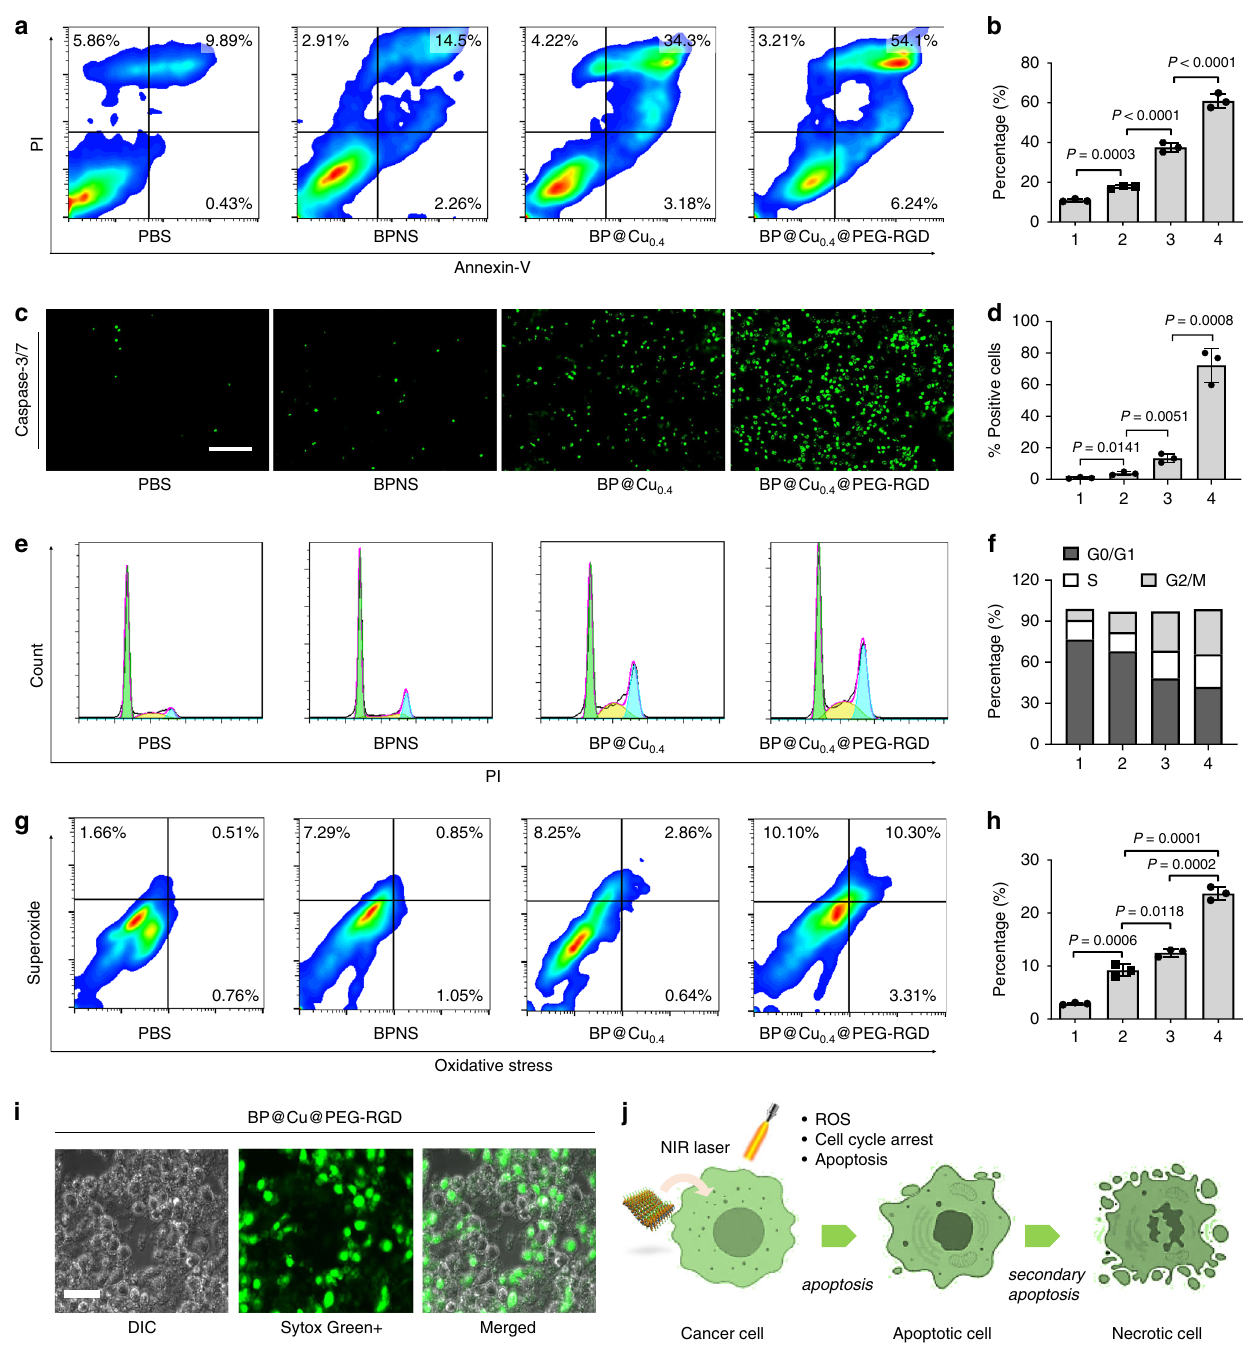
Fig. 5 Cellular effects of BP@Cu 0.4 @PEG-RGD in cancer cells. B16F10 cells were treated with (1) PBS (control), (2) BPNS (100 ppm), (3) BP@Cu 0.4 (100 ppm of BPNS), or (4) BP@Cu 0.4 @PEG-RGD (100 ppm of BPNS) for 24 h. NIR irradiation (808 nm, 1 W cm − 2 , 2 min) was applied to all cells after